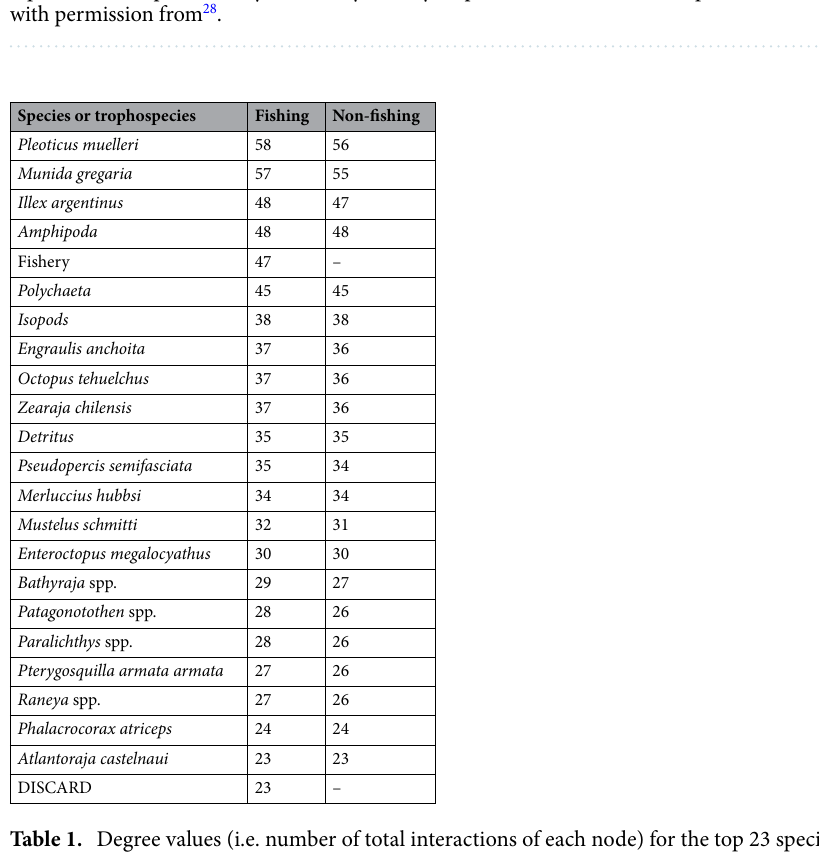
Figure 2. Simplified food web representation of the most important species in terms of the degree, relative biomass and taxon representation. Arrows represent energy and biomass fluxes direction, yellow arrows represent fluxes produced by the fishery activity (capture and discard consumption). The image was obtained with permission from 28 .